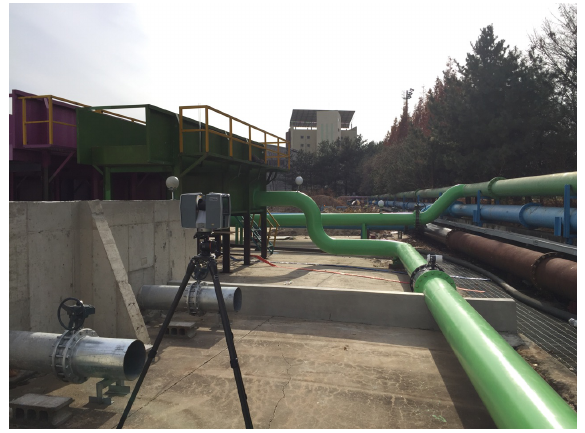
Figure 2. Pre-processed PCD acquisition using a Trimble X5 on-site.